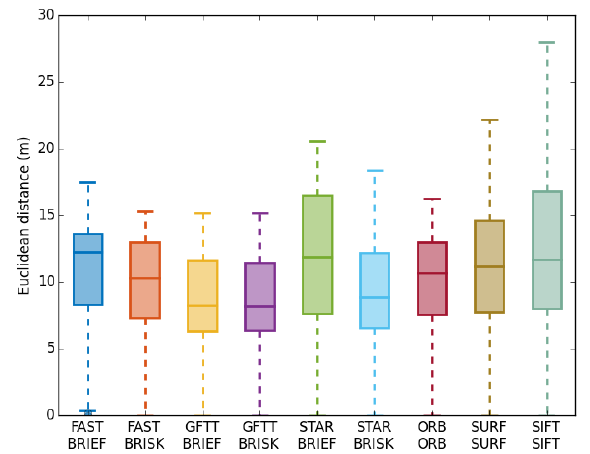
Figure 6. Absolute translation error